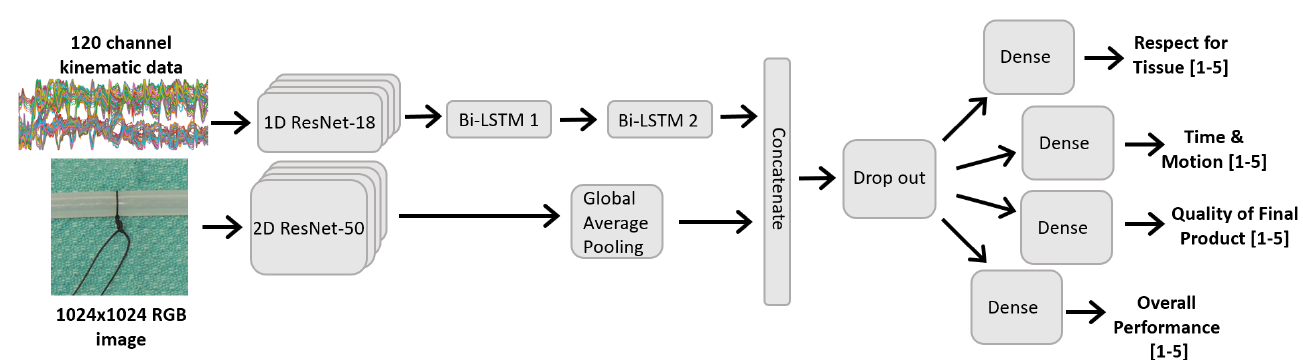
Figure 3. Images were analyzed using a ResNet-based network, and the kinematic data was analyzed using a 1D ResNet-18 as a ‘feature extractor’, followed by 2 bidirectional LSTM layers. The com- bined multi-modal network is concurrently trained on both the image and kinematic data as input, and predicts all four GRS